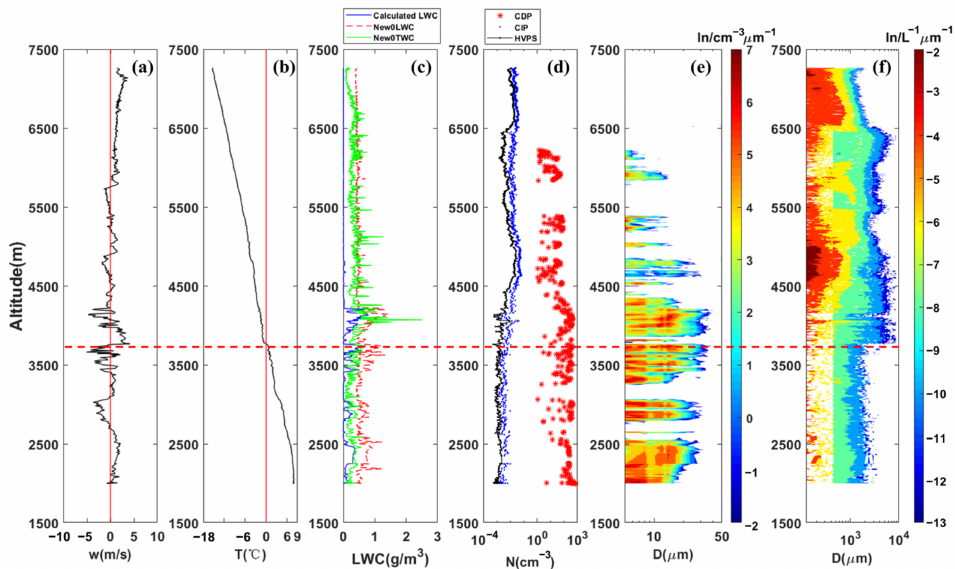
Figure 9. The aircraft observation data set of V1 on 22 May 2017 in the convective cell, ( a ) vertical velocity (the red line is 0, units: m s − 1 , ◦ C); ( b ) temperature (units: ◦ C, the red line is 0); ( c ) calculated liquid water content (calculated LWC), probe detected liquid water content (New0LWC), probe detected total water content (New0TWC) (units: g m − 3 ); ( d ) particle number concentration of the CDP, the CIP, and the HVPS (units: cm − 3 ); ( e ) particle spectrum of CDP (units: cm − 3 µ m − 1 ); ( f ) particle spectrum of the CIP (100–400 µ m) and the HVPS (400–8700 µ m) (units: L − 1 µ m − 1 ). The red dotted line is the 0 ◦ C layer.